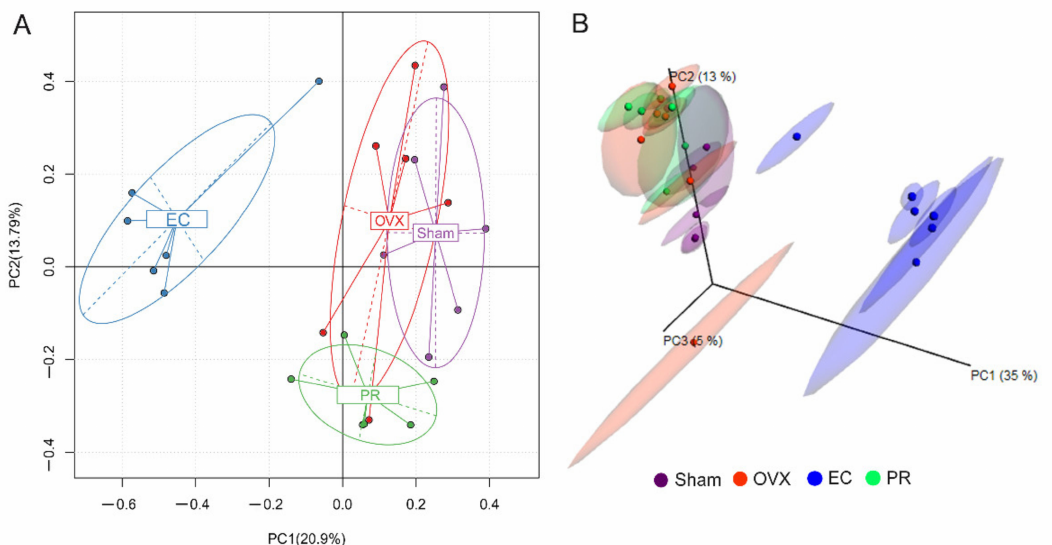
Figure 3. PCA and PCoA plots based on operational taxonomic unit (OTU) abundance. ( A ) Principal component analysis (PCA) plot. ( B ) Principal coordinate analysis (PCoA) plot of the unweighted UniFrac distance matrix. Number in brackets represents contributions of principal components ( A ) or coordinate ( B ) to differences among samples. A dot represents each sample, and different colors represent different groups.